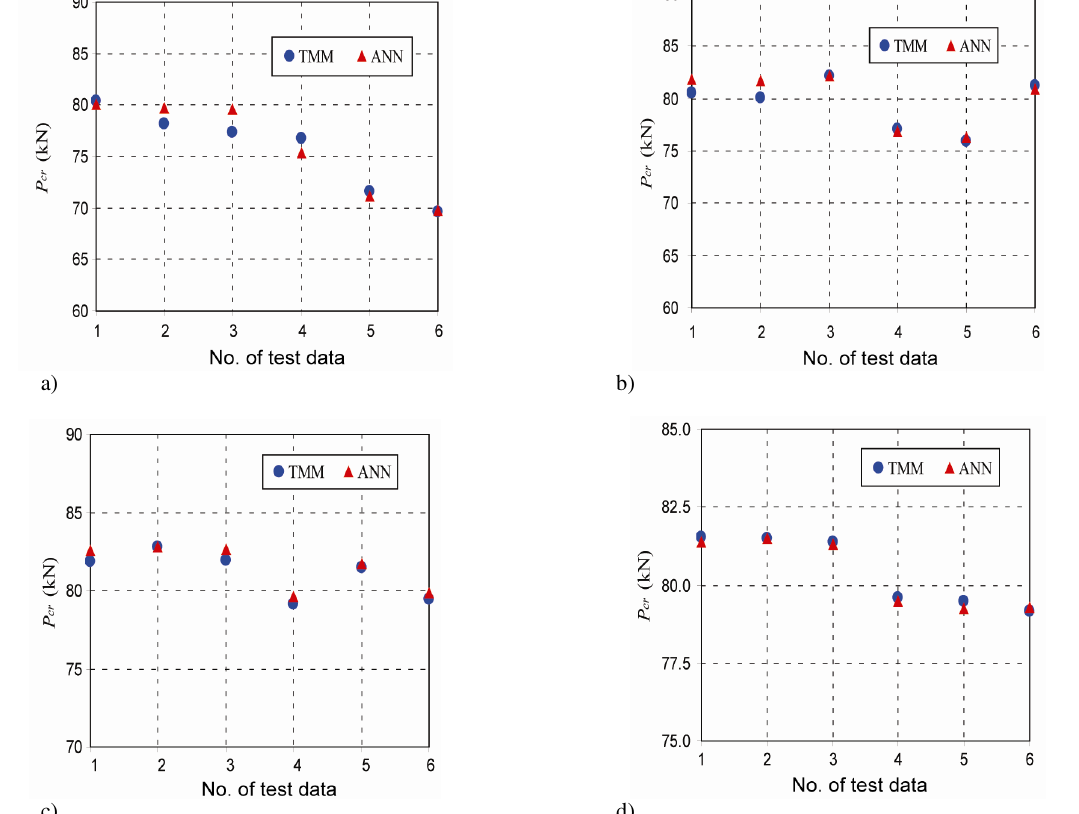
Fig. 7. Plotting of estimation performances for: (a) fixed-free; (b) pinned-pinned; (c) fixed-pinned; and (d) fixed-fixed supported